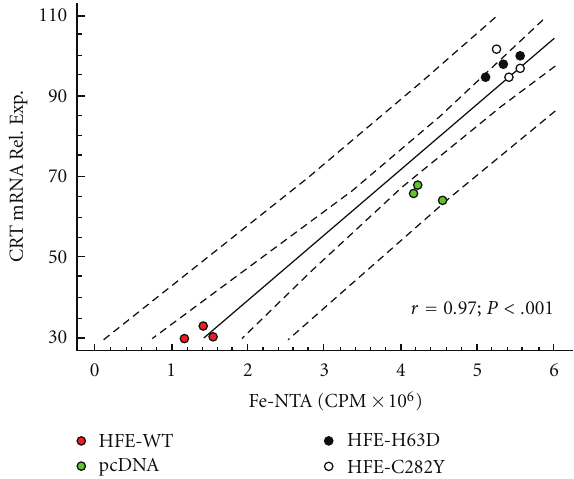
Figure 2: Regulation of CRT mRNA by iron. Linear regression analysis of the correlation between intracellular iron levels (3 μ M ferric nitrilotriacetate ( 55 Fe–NTA) were used as iron source), and CRT mRNA pools in HepG2 cells overexpressing the WT or mutated (C282Y or H63D) HFE variants (HepG2 cells transfected with the empty pcDNA3 vector were used as negative control). Each dot represents the average of one experiment with three replicates. r = 0 . 97; P < . 001. Inner dashed curves represent 95% confidence intervals for the mean value of CRT at any selected CPM value. Outer dashed lines are 95% prediction limits for new observations. Modified from Pinto et al., 2008